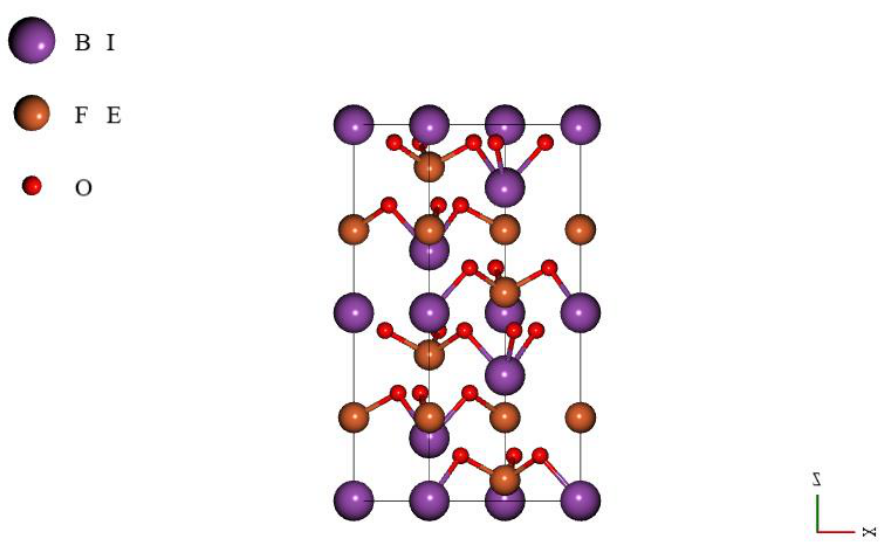
Figure 2. The crystal structure of Bismuth ferrite with hexagonal coordinates, drawn using BURAI software (software development credit: Satomichi Nishihara ).